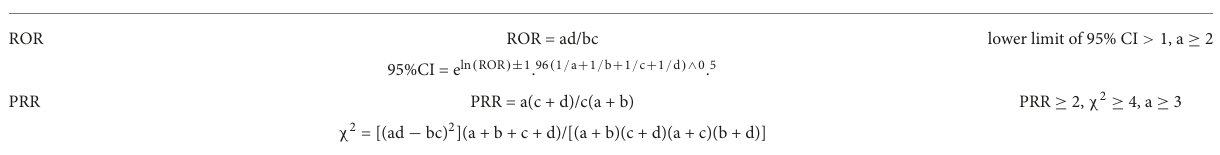
TABLE 1 Summary of algorithms used for signal